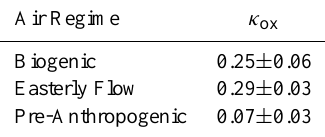
Table 2. κ ox for select air